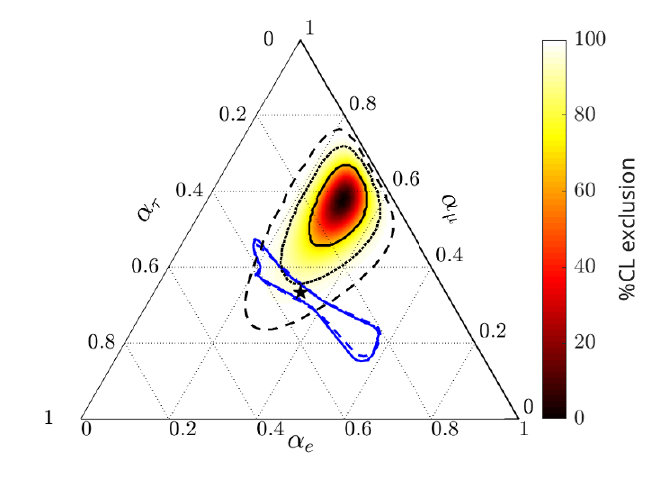
Figure 4 . Allowed regions for the neutrino (cid:13)avor composition at the Earth assuming black hole production in neutrino-nucleon interactions in IceCube. The solid, dotted and dashed black contours show the 68%, 95% and 99.7% CL respectively. The 3 (cid:27) regions for Standard Model interactions (without BH formation) after neutrino oscillation with any (cid:13)avor combination at the source are shown in blue contours. The solid blue line is obtained from normal ordering and dashed line is from inverted ordering. Neutrino oscillation parameters are taken from NuFIT 4.1 [89, 90]. The black star in the centre indicates the (1 : 1 : 1) (cid:13)avor